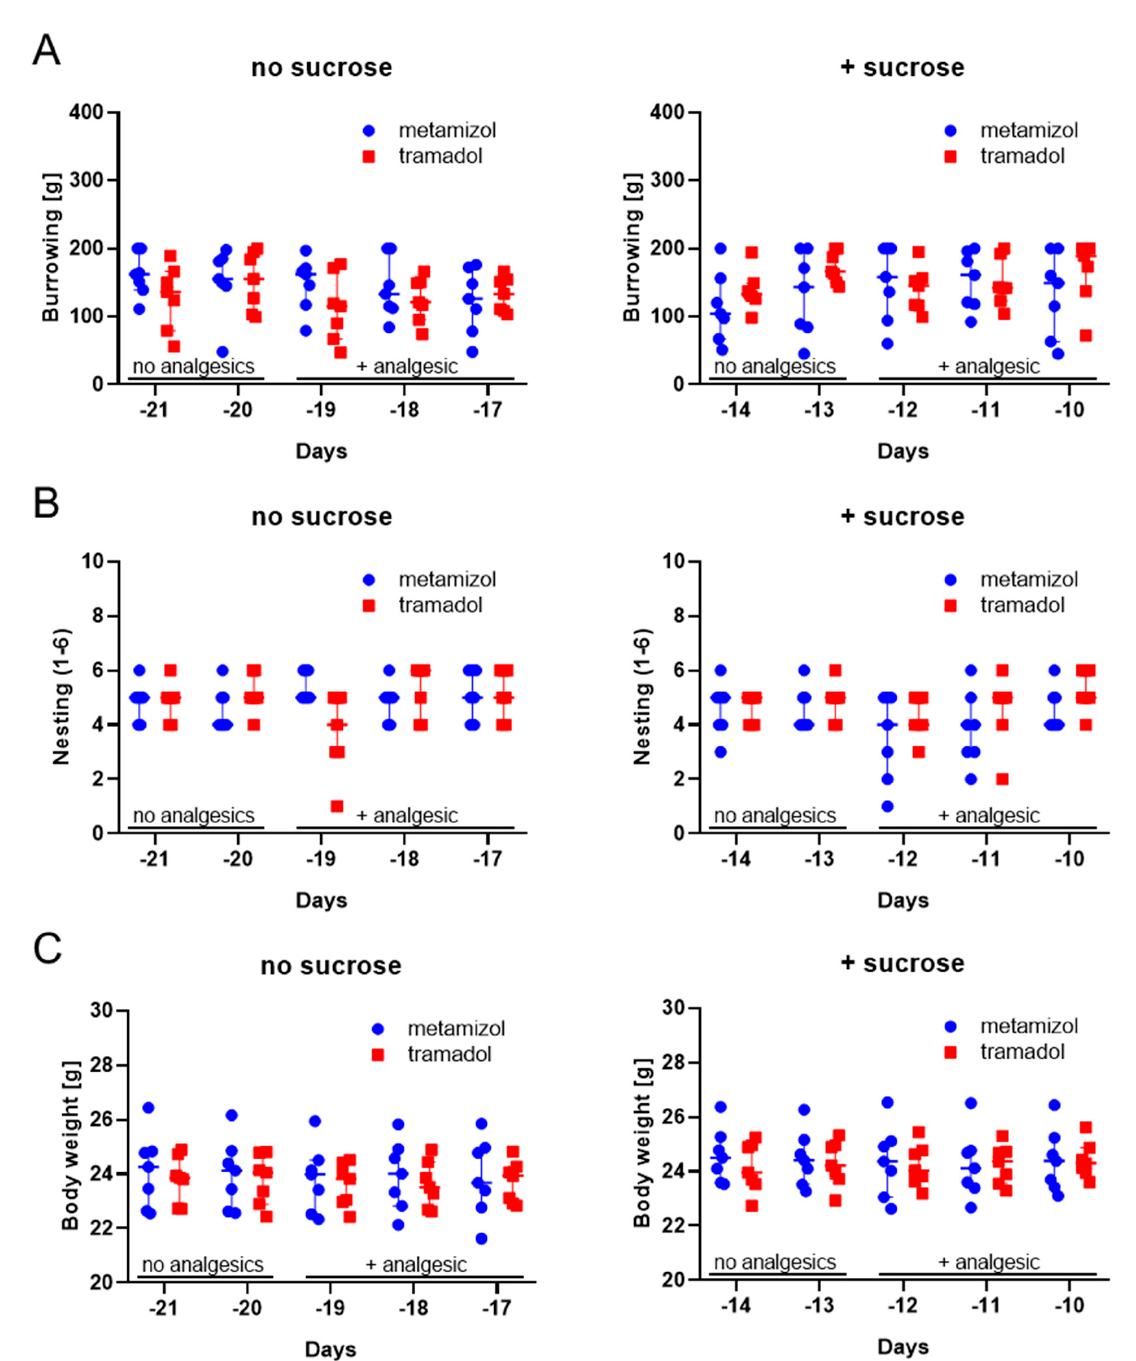
Figure 2. Impact of analgesics on burrowing as well as nesting activity and body weight during the pre-experimental phase. Burrowing activity ( A ), nesting activity ( B ), and percentage of body weight compared to day − 26 ( C ) was assessed, using drinking water without or with sucrose. No statistically significant di ff erences between metamizole and tramadol treatment were obtained (using two-way repeated measure ANOVA with Sidak’s correction for multiple comparisons). Metamizole: n = 7; tramadol: n =